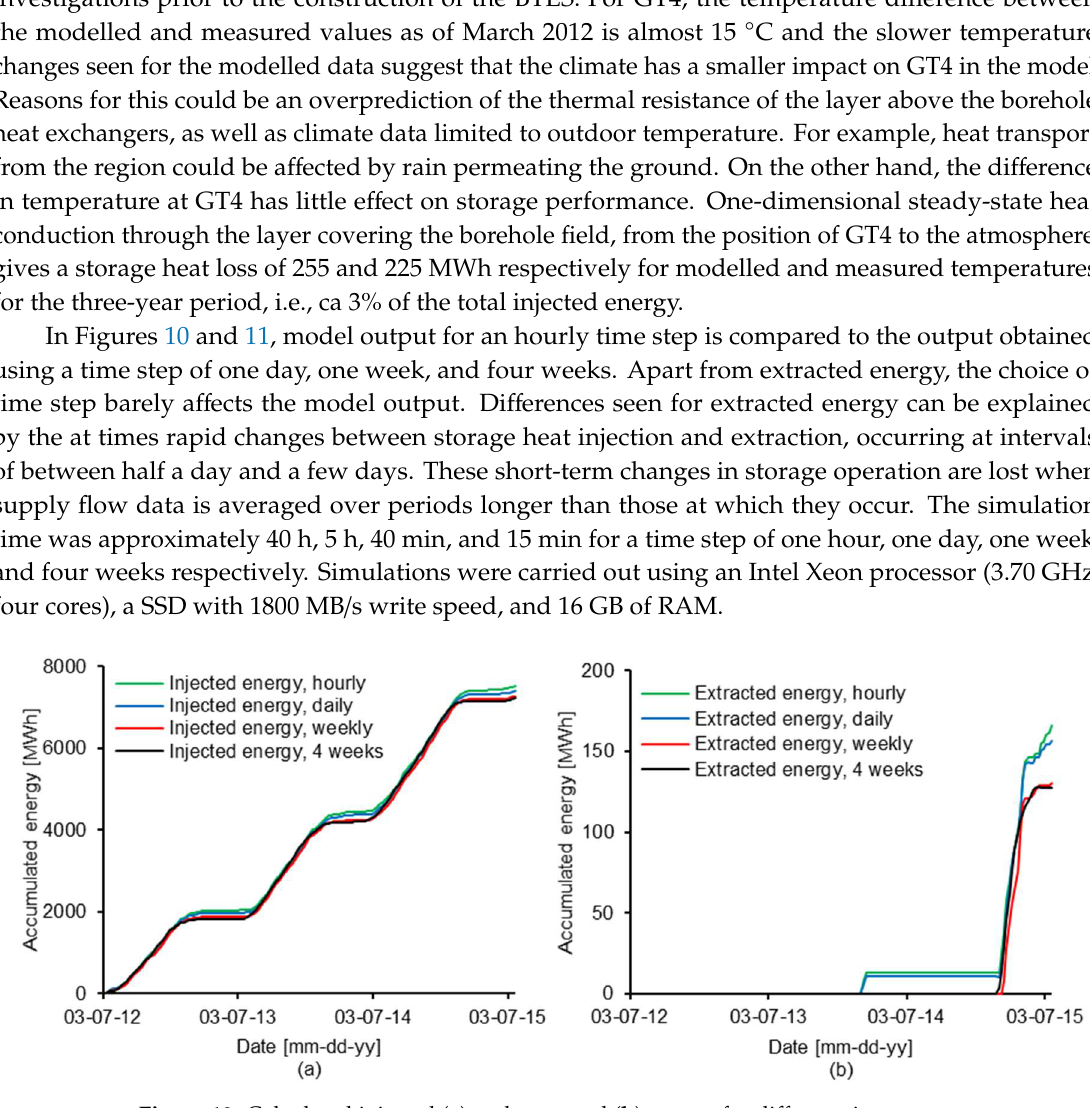
Figure 11. Calculated ground temperatures, ( a ) GT1, ( b ) GT2, ( c ) GT3 and ( d ) GT4, for different time steps. 4.2. Parametric Study 4.2.1. Borehole Spacing A key parameter for BTES is the borehole spacing because this will affect the volume into which heat is injected and the degree to which the boreholes thermally interact with each other. In Figure